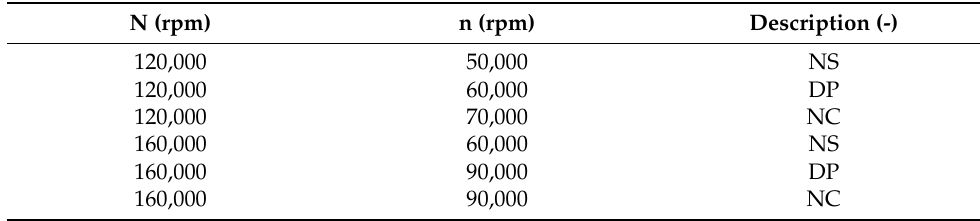
Table 2. Chosen fan-operating